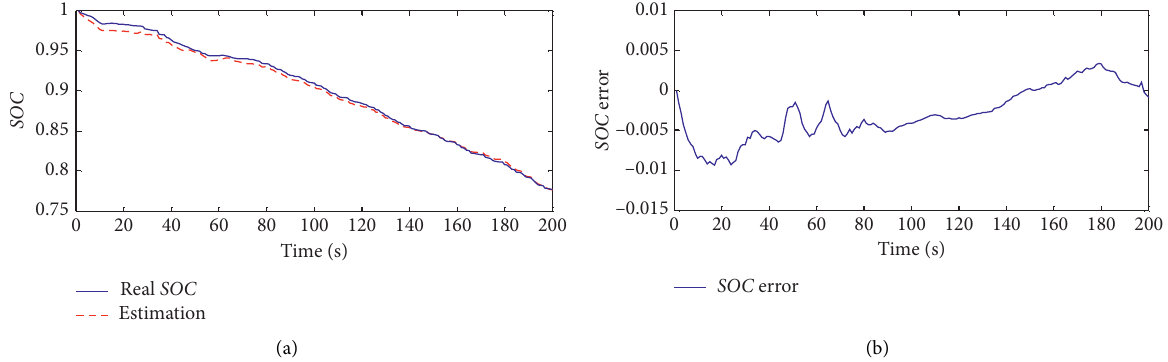
Figure 9: SOC estimation results and errors of supercapacitors.